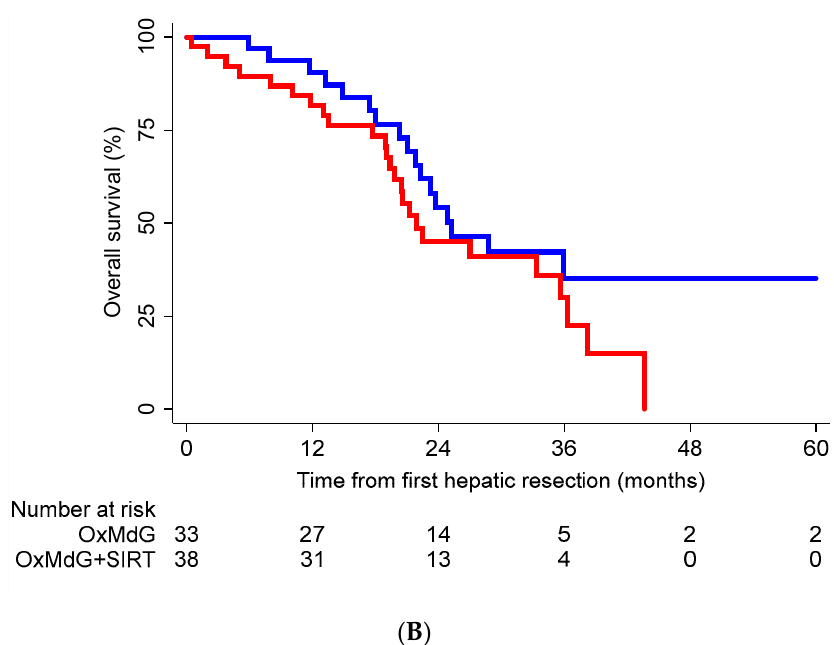
Figure 3. Kaplan-Meier curves for time to resection ( A ) and time to death ( B ). ( A ) Kaplan-Meier curve of time from randomisation to hepatic resection for each treatment group during the FOXFIRE study duration. ( B ) Kaplan-Meier curve of time from hepatic resection to death for each treatment group during the FOXFIRE study duration.